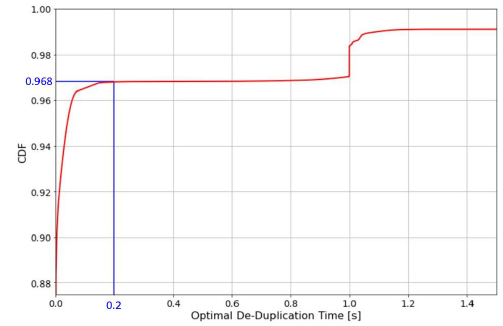
Figure 16. Plot of the distribution of the groups of duplicates over the optimal de-duplication time expressed in